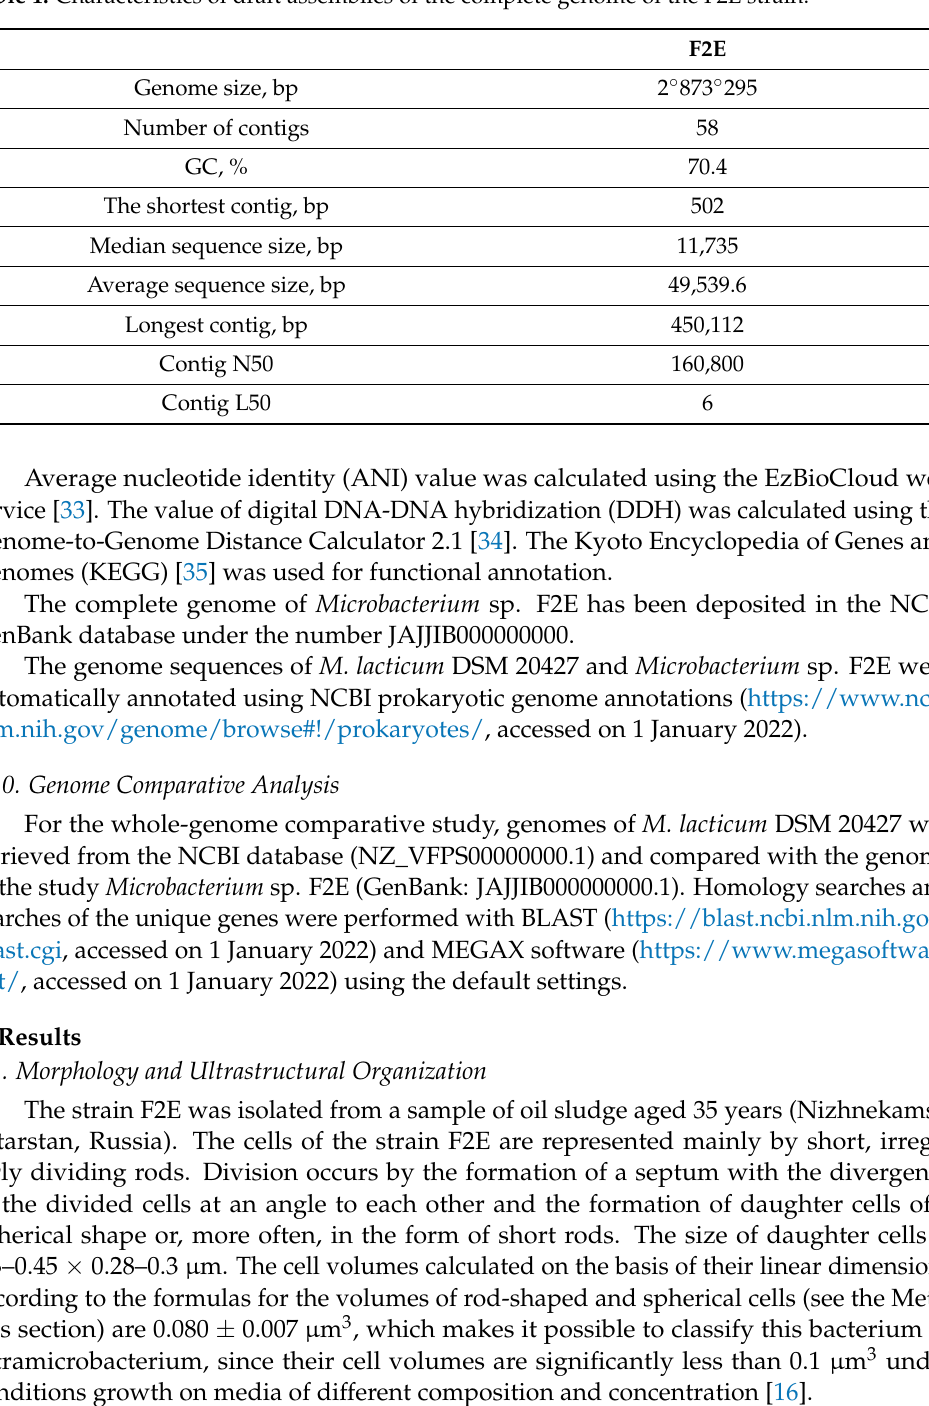
Table 1. Characteristics of draft assemblies of the complete genome of the F2E strain.